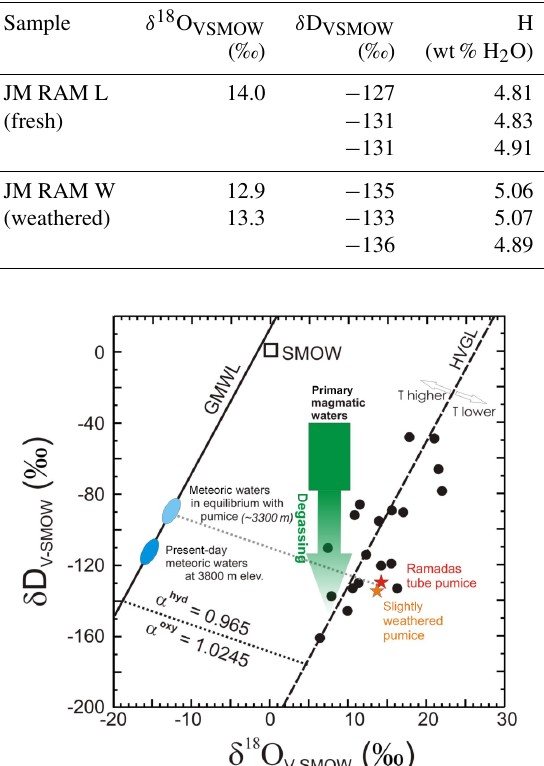
Figure 5. Oxygen and hydrogen isotope composition of tube pumice, meteoric waters in equilibrium with the glasses, and present-day local meteoric waters. Primary magmatic waters from Sheppard et al. (1969); degassing trend (green arrow) from Tay- lor et al. (1983); HVGL is hydrated volcanic glass line from Tay- lor (1968); grey circles are hydrated silicic volcanic glasses from Taylor (1968), Cerling et al. (1985), and Compton et al. (1999); SMOW is the Standard Mean Ocean Water; GMWL is the Global Meteoric Water